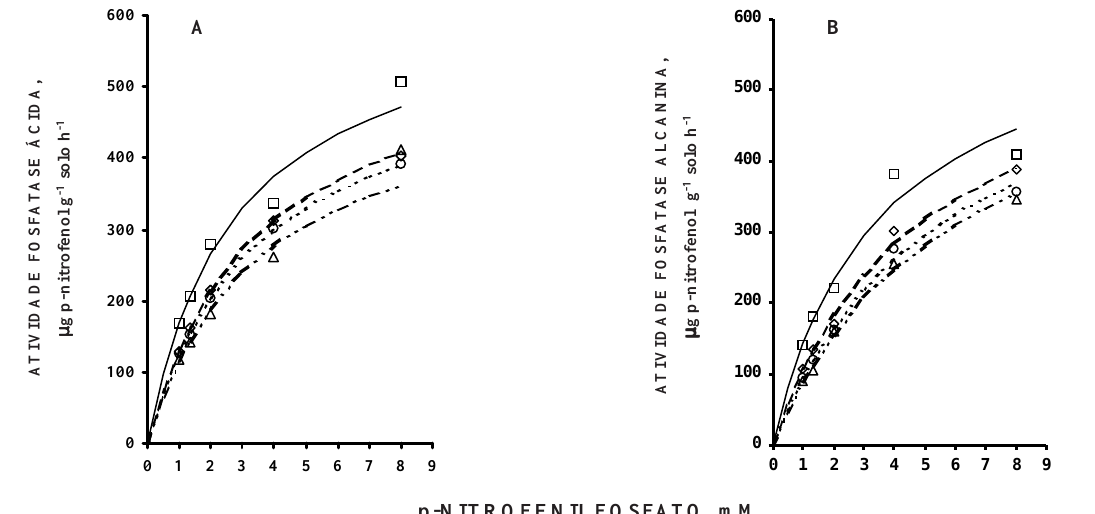
Figura 1. Curvas de saturação pelo substrato das fosfatases ácidas (A) e alcalinas (B), produzidas em solos com saturação por base de 76,6 % ( _____ _______ ), 68,0 % ( __ __ (cid:224) (cid:224) (cid:224) (cid:224) (cid:224) __ __ ), 45,0 % ( - - - - o - - - -- - - - o - - - -- - - - o - - - -- - - - o - - - -- - - - o - - - - ) e 32,0% ( .. D D D D D .. ). As curvas para fosfatases ácidas e alcalinas foram obtidas em tampão MUB com